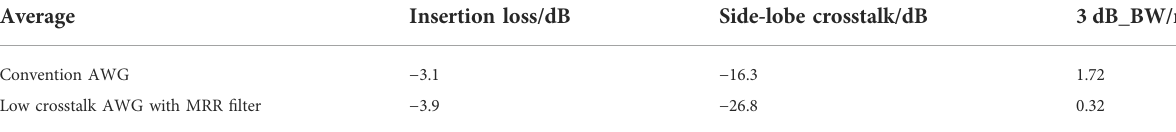
TABLE 5 Comparison of the performance of conventional AWG and low crosstalk AWG with MRR fi lter.